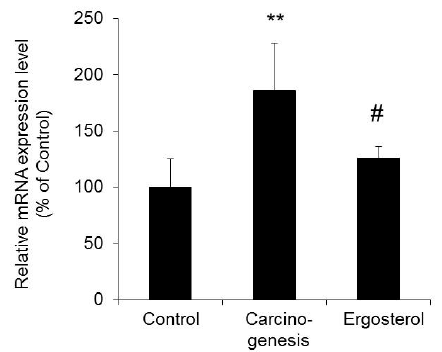
Figure 2. The mRNA expression level of cyclin D1 in bladder epithelial cells. The bladders were removed from rats in the control, carcinogenesis, and ergosterol-treated groups, and the mRNA expression level of cyclin D1 was measured using real-time RT-PCR and normalized to those of 18S rRNA. The data are presented as percentages of the mean value in the control group, which was set at 100%. The data show the mean ± SD from five rats per group. Tukey’s test, ** p < 0.01 vs. the control group, # p < 0.05 vs. the carcinogenesis group.